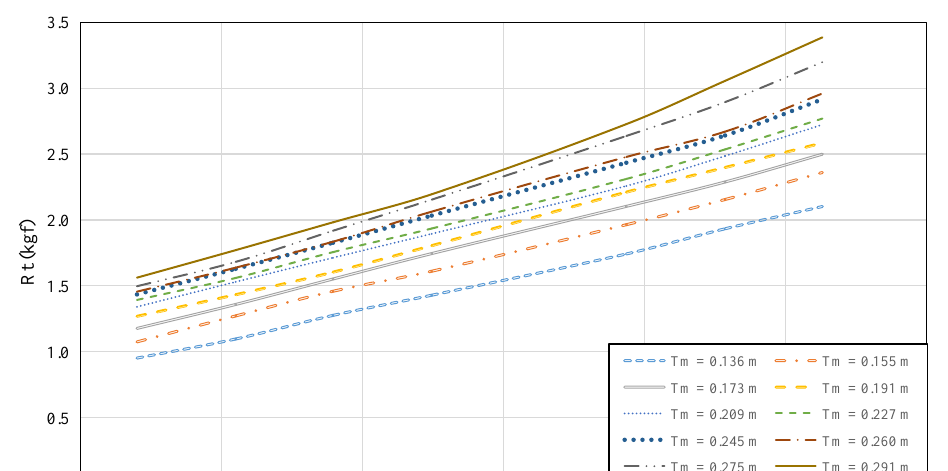
Figure 2. The test model of the 13500TEU container ship.